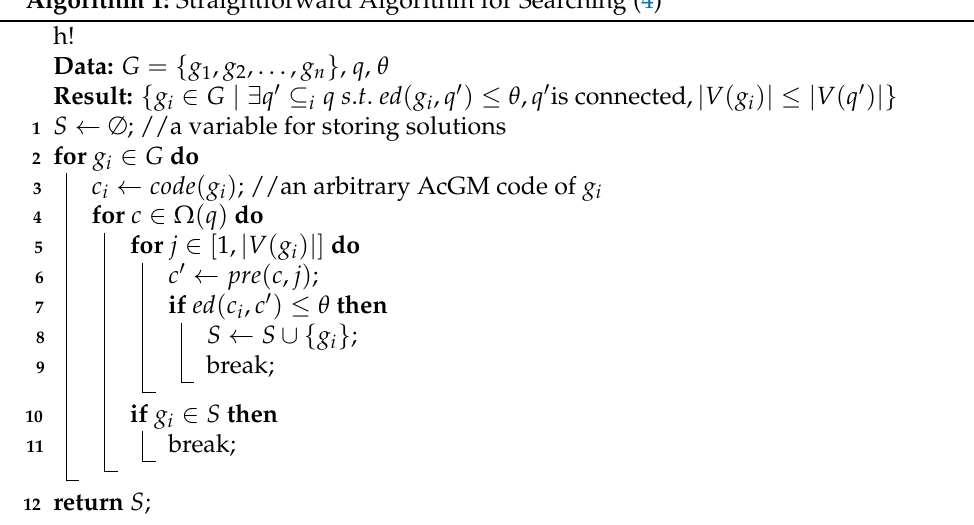
Algorithm 1: Straightforward Algorithm for Searching